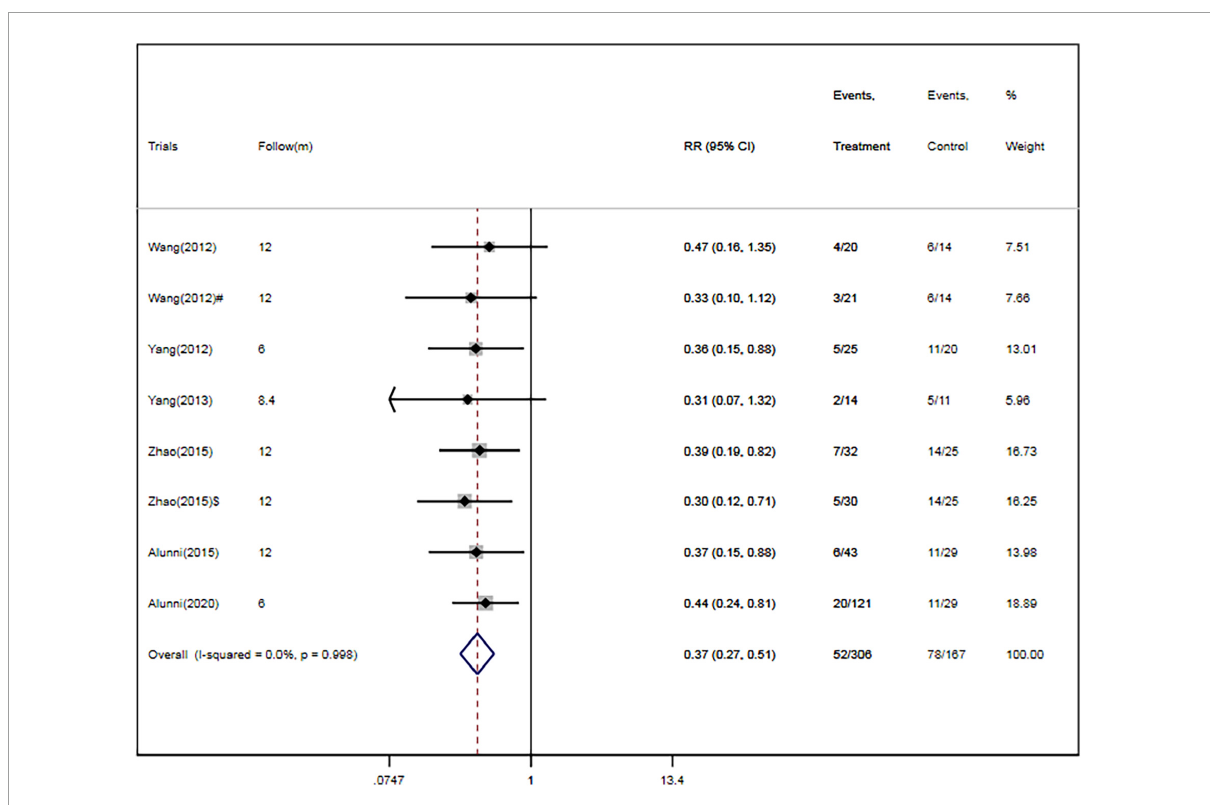
FIGURE5 CSWT plus OMT is associated with a decreased rate of rehospitalization. Fixed-effects model ( I 2 = 0.0%). CSWT, cardiac shock wave therapy; OMT, optimal medical therapy; RR, relative risk; CI, confidence interval. # Patients treated with short-term regimen of CSWT; $ , patients treated with an expanding scope